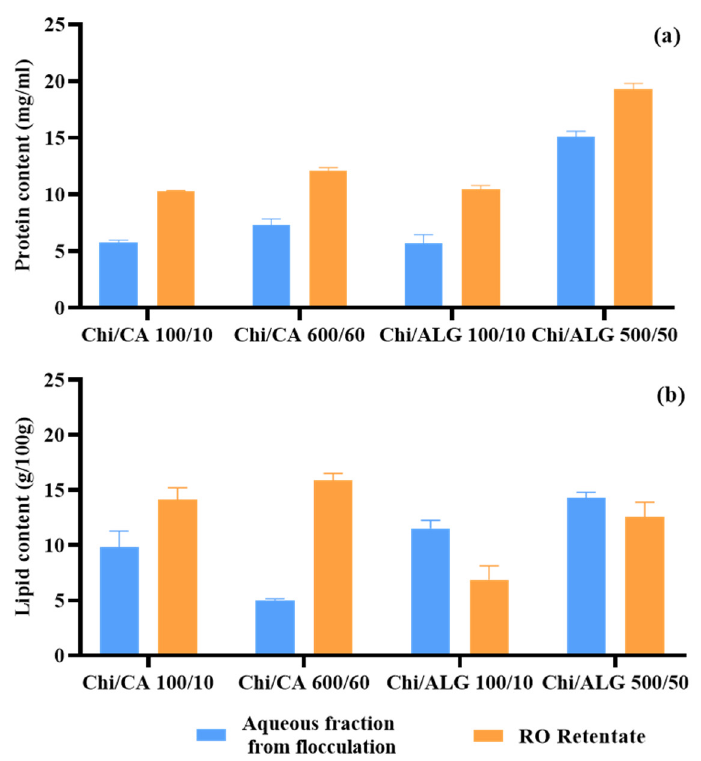
Figure 11. Protein ( a ) and lipid ( b ) content of reverse osmosis retentates, for different combinations of chitosan/carrageenan and chitosan/ alginate.